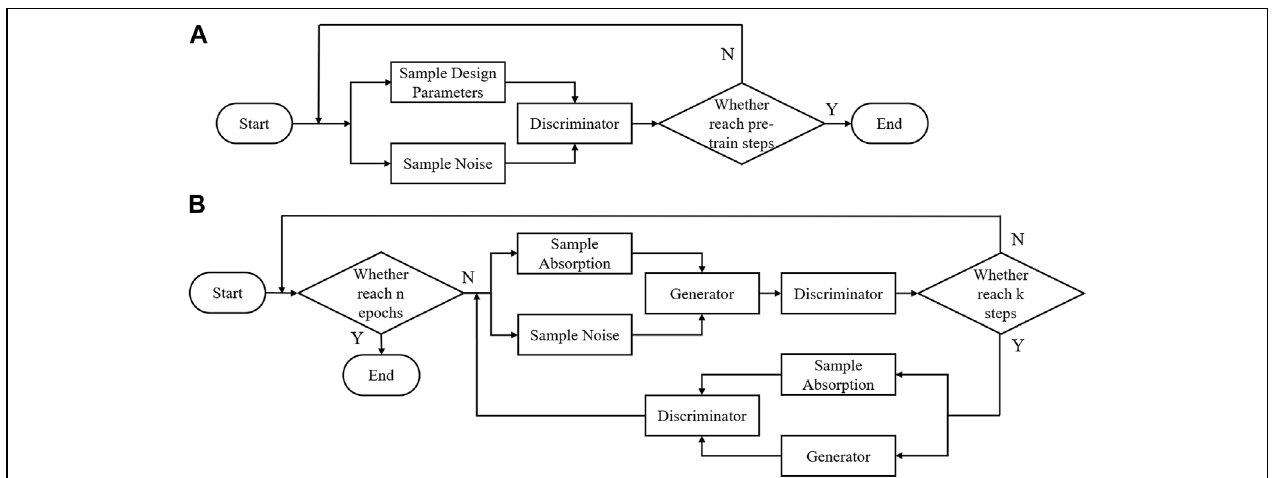
FIGURE 3 | Schematic diagram of the entire training process. (A) indicates the pre-training progress. (B) represents the entire training progress.